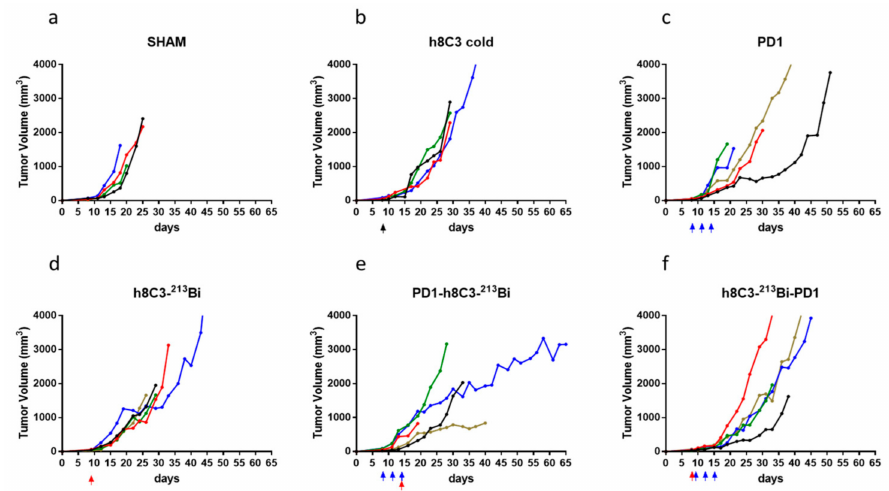
Figure 2. Combination therapy of Cloudman S91 tumor bearing male DBA / 2 mice with anti-PD-1 mAb and one dose RIT with 213 Bi-h8C3 mAb. The mice in groups of five were treated with: ( a ) sham injections with PBS; ( b ) a single dose of 80 µ g unlabeled (cold) h8C3 on Day 8 after tumor cells inoculation; ( c ) three doses of 250 µ g anti-PD-1 mAb on Days 8, 11, and 14; ( d ) one dose of 400 µ Ci 213 Bi-h8C3 on Day 8; ( e ) three doses of anti-PD-1 mAb on Days 8, 11, and 14 and one dose of 400 µ Ci 213 Bi-h8C3 on Day 14; ( f ) one dose of 400 µ Ci 213 Bi-h8C3 on Day 8 and three doses of anti-PD-1 mAb on Days 9, 12, and 15. Each tumor volume curve represents a single animal. Black, blue, and red arrows indicate the injection of cold antibody, anti-PD1 antibody, and RIT